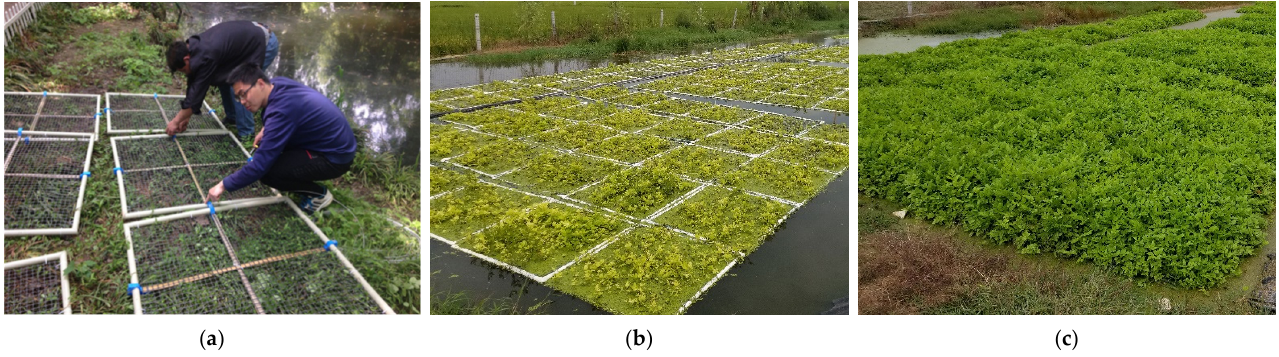
Figure 1. Construction of the integrated floating wetland system. ( a ) The 1 m × 1 m square floating beds units preparation; ( b ) experiment site on day 0, plants were pre-cultured for one week; ( c ) experiment site on day 35.